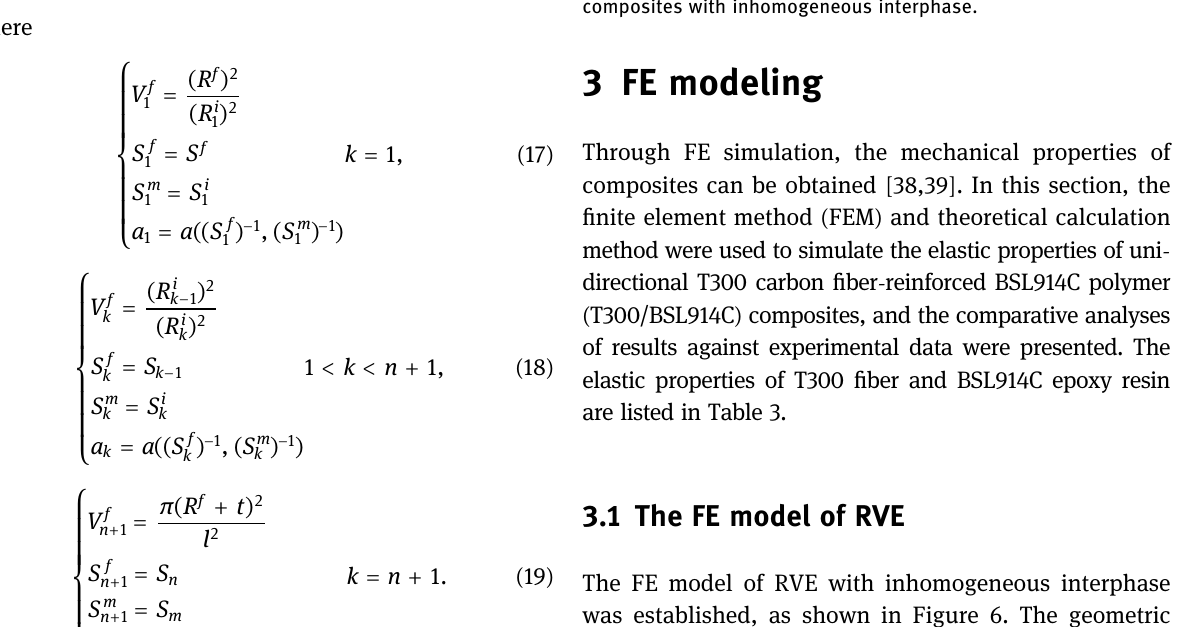
Figure 5: Theoretical calculation framework of elastic modulus of composites with inhomogeneous